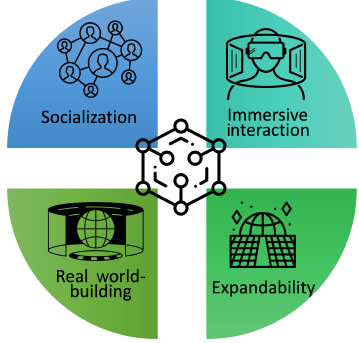
Fig. 3 Four characteristics of the